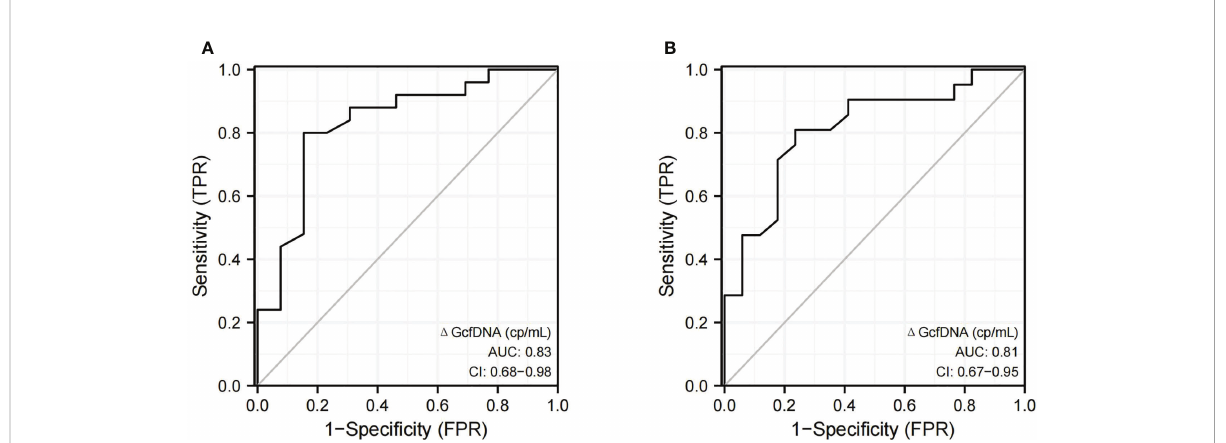
FIGURE 4 The discrimination capacity of D GcfDNA(cp/mL). Receiver operating curves of (A) D GcfDNA(cp/mL) for distinguishing pathologically proven